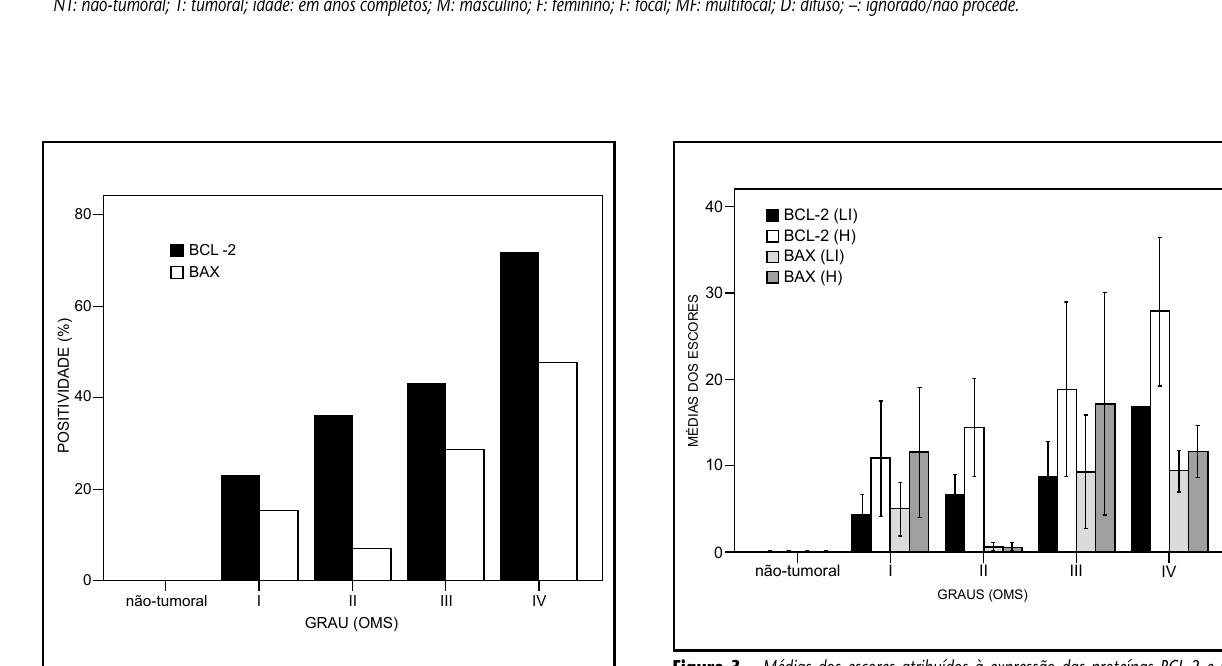
Figura 3 – Médias dos escores atribuídos à expressão das proteínas BCL-2 e BAX (LI e H) detectada por imuno-histoquímica segundo a classificação histológica dos casos avaliados. LI: labelling index;